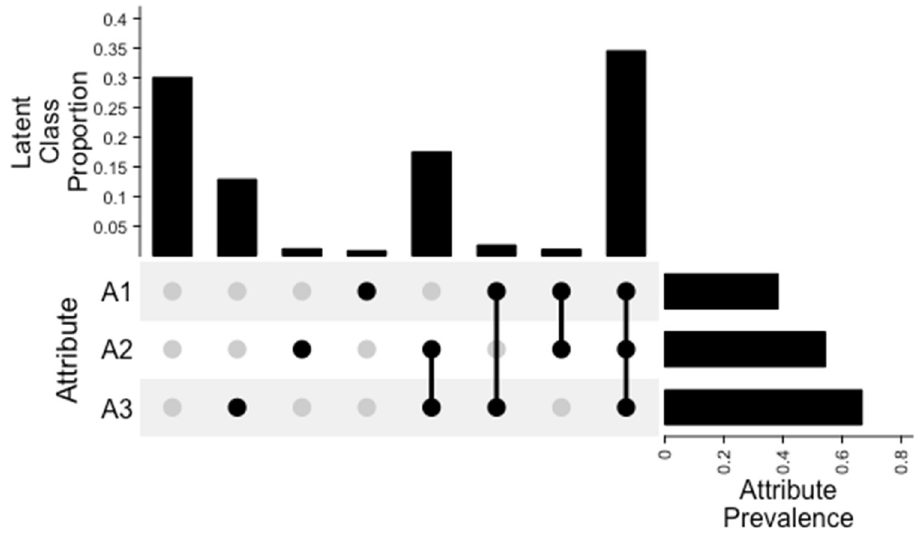
Figure 10. Attribute prevalence and latent class proportions.